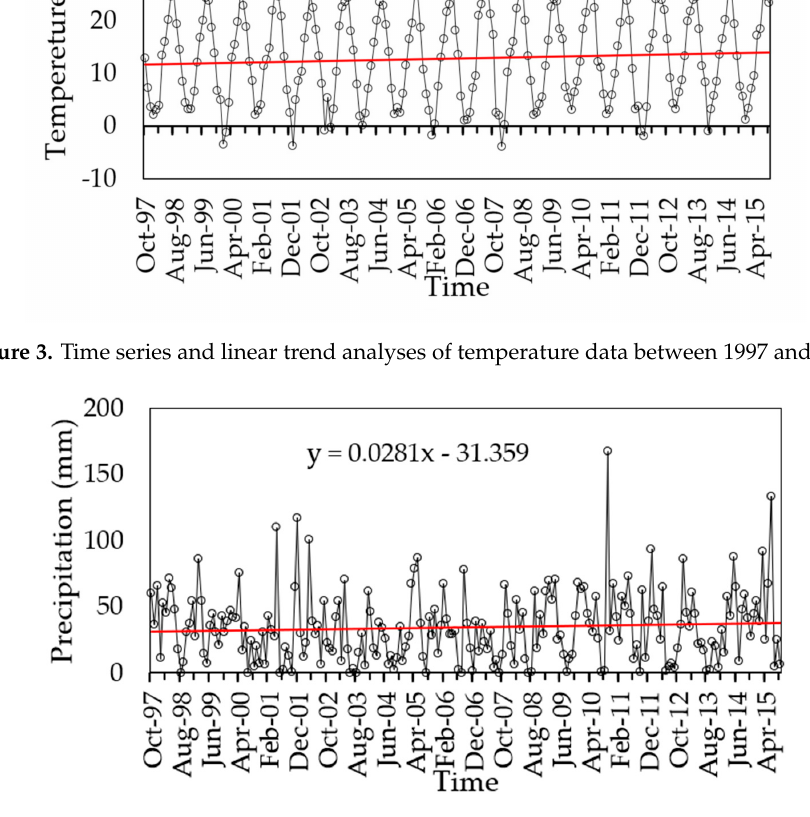
Figure 4. Time series and linear trend analyses of precipitation data between 1997 and 2015.